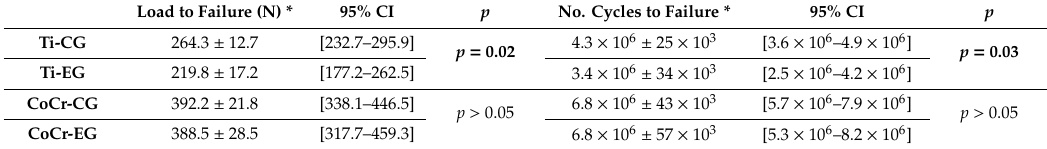
Table 3. Summary of load-to-failure and total number of cycles to failure for all tested groups.